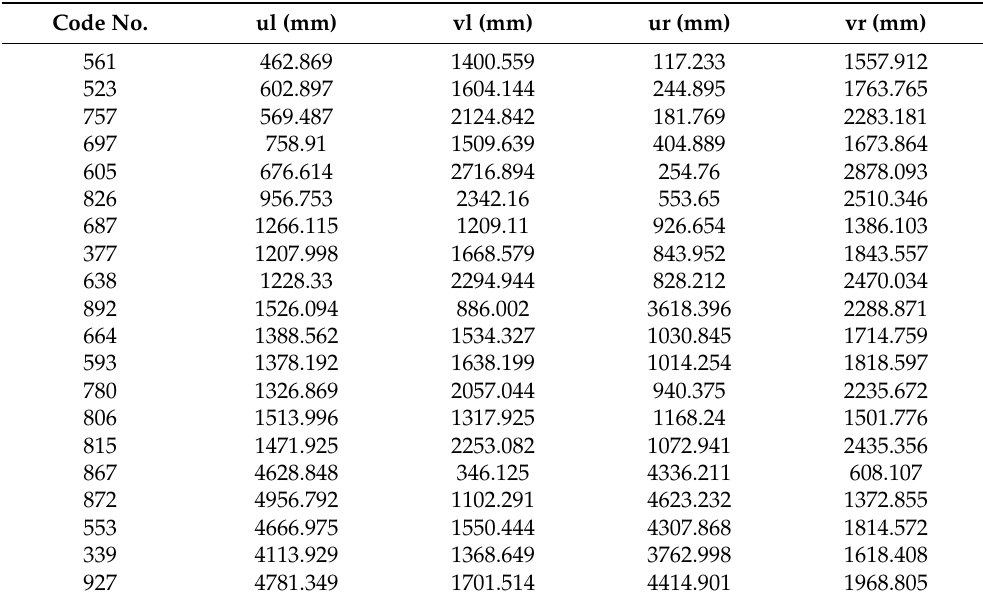
Table 3. Sea surface base plane calibration feature point coordinates. Code